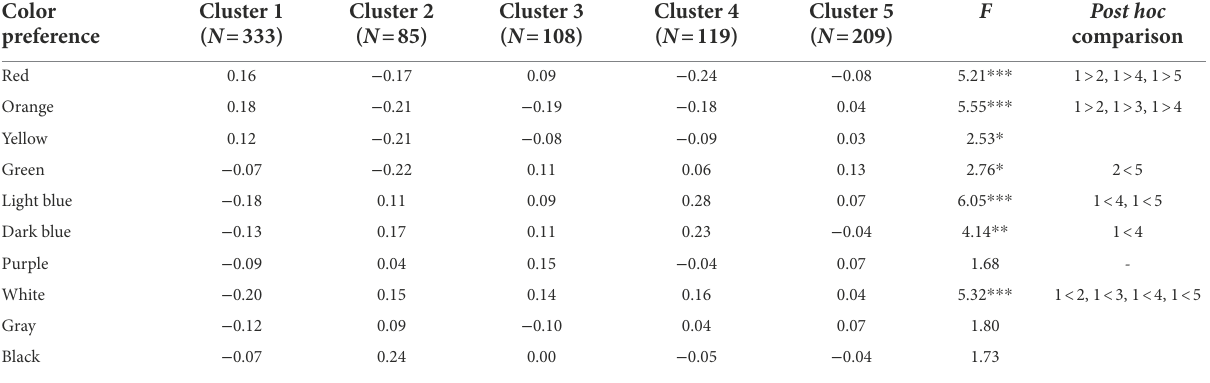
TABLE 6 Comparison between five clusters’ color